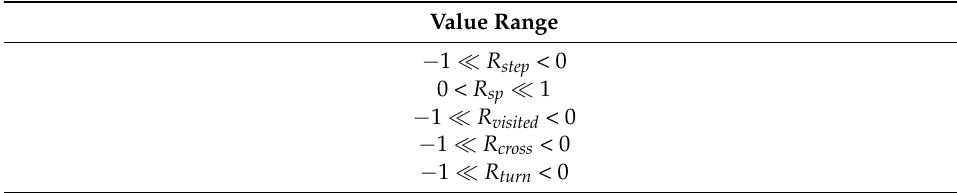
Table 3. Reward function parameters value